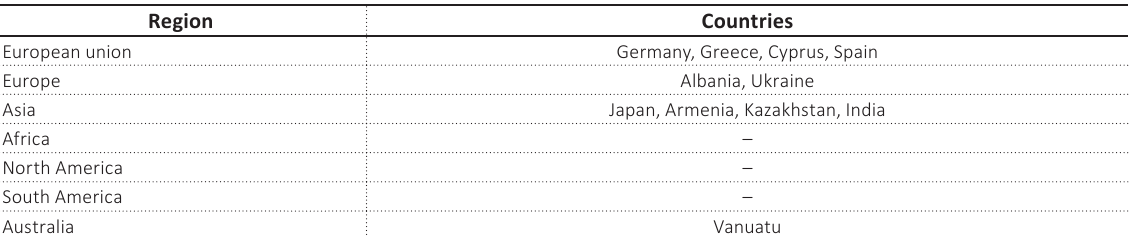
Table 7. Geo- and national banking systems containing threats to the stability of the global banking system in the near